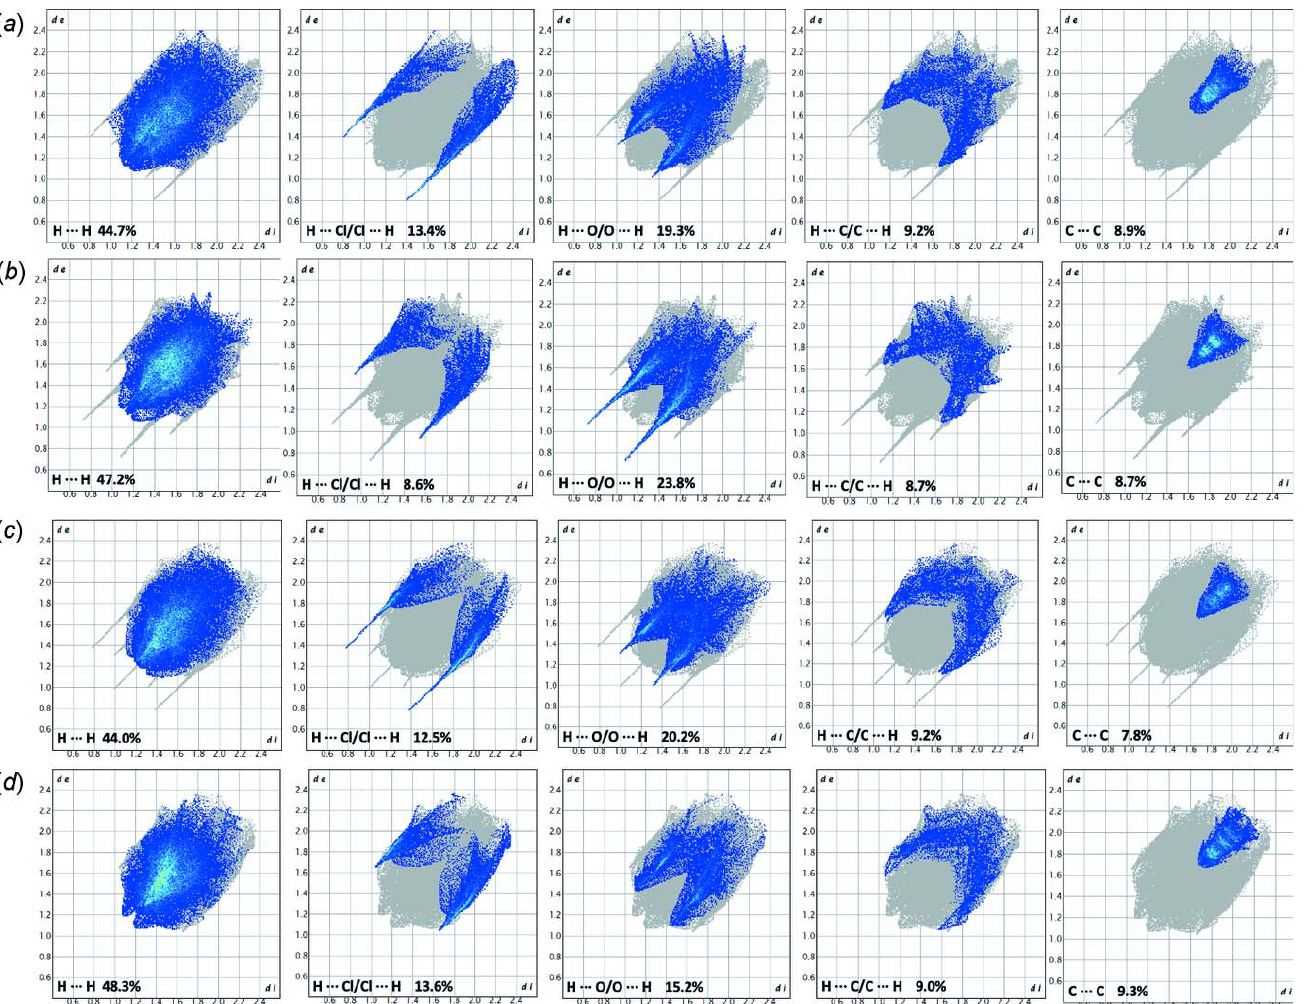
Figure 4 The two-dimensional fingerprint plots for pseudopolymorphs of BCl with ( a ) two water molecules, ( b ) four water molecules, ( c ) one molecule of ethanol and 0.5 molecules of water, and ( d ) one methanol